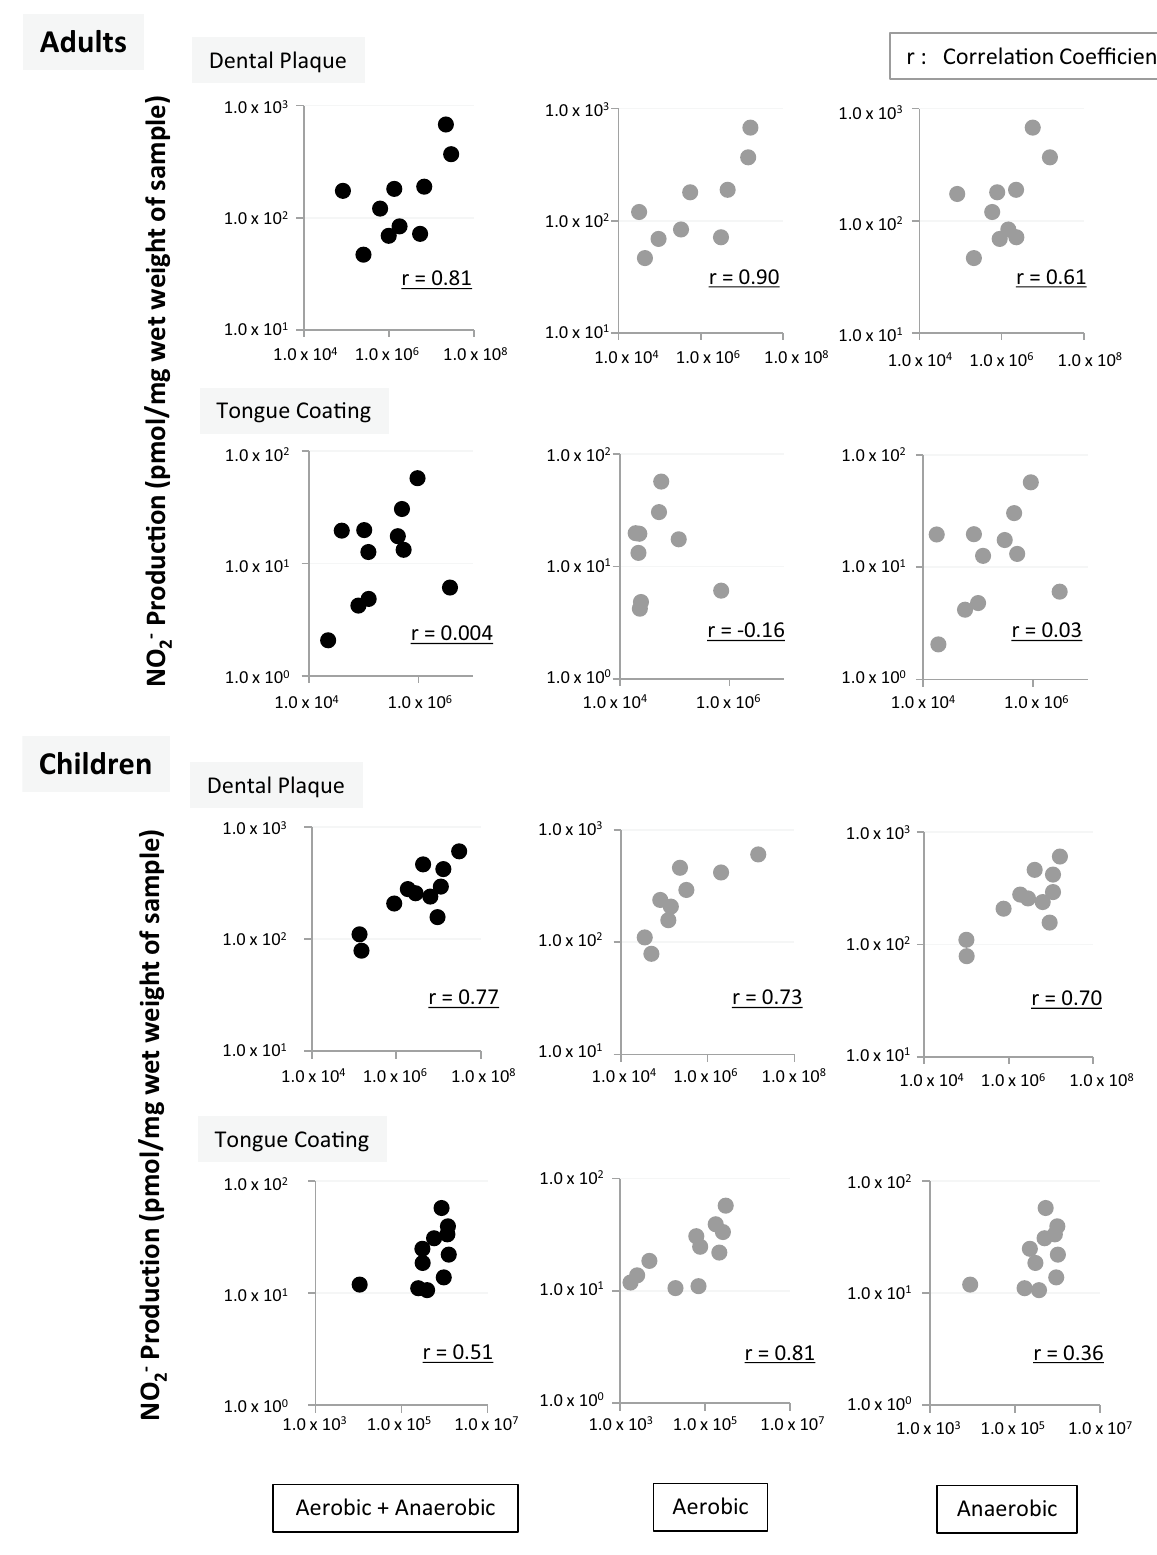
Figure 4. Correlation between NO 2− -producing activity and the number of NO 2− -producing bacteria (aerobic, anaerobic, and aerobic plus anaerobic conditions) in the dental plaque and tongue coating samples from adults and children. Both axes are displayed on logarithmic scales. r correlation coefficient, Aerobic the bacteria on the blood agar plate were cultured aerobically, Anaerobic the bacteria on the blood agar plate were cultured